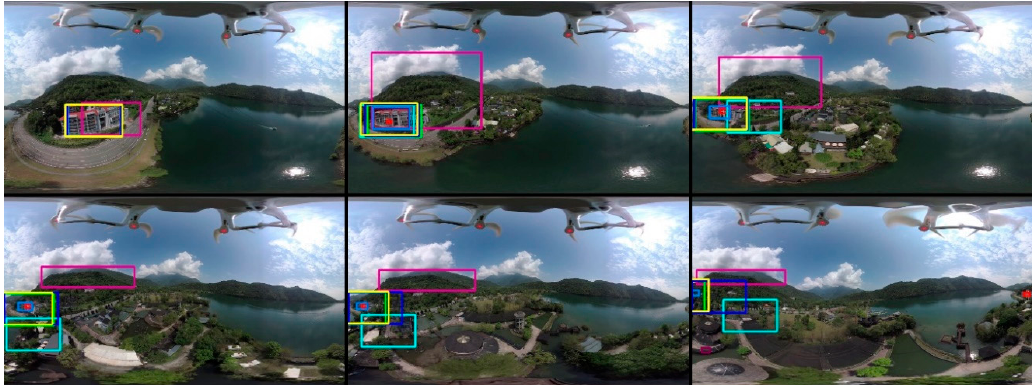
Figure 7. Tracking results on 360-degree video sequence 4 (tracking windows with different colors: MOSSE MIL MedianFlow BOOST TLD KCF GOTURN CSRT).